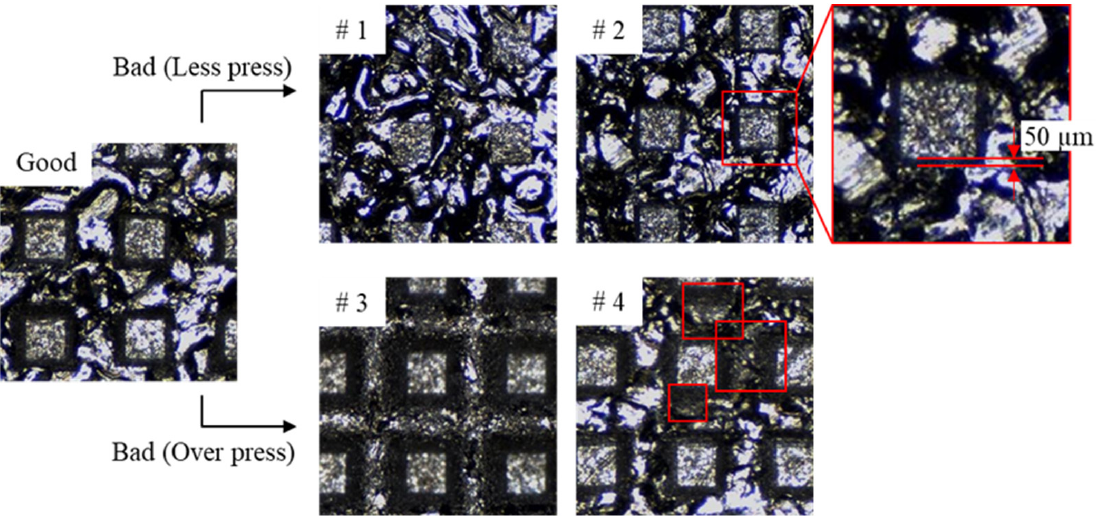
Figure 3. Classification criteria between good and bad specimens during human labeling.